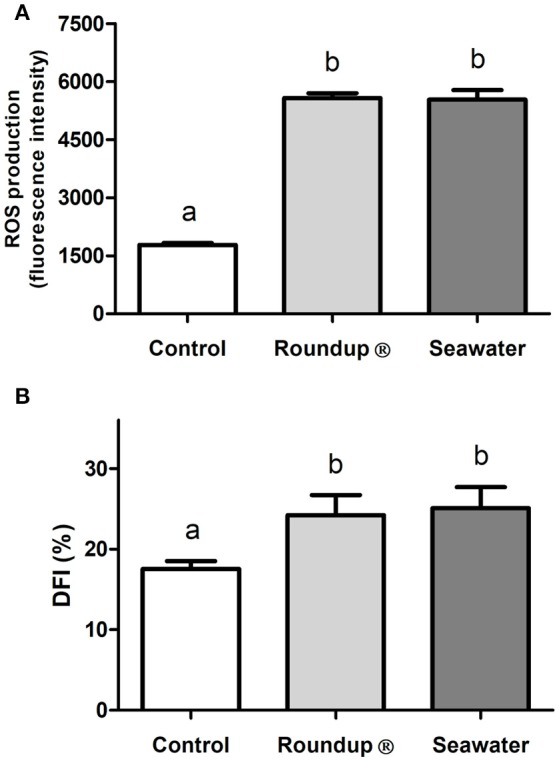
Effects in erythrocytes of Odontesthes humensis of exposures to Roundup® and to seawater. Effects of exposures to Roundup® Transorb [10 mg.L−1 (acid equivalent) of glyphosate] and to seawater (30 ppt) for 24 h on ROS (Reactive Oxygen Species) production (A) and in DFI (DNA Fragmentation Index, %) (B). Mean ± SEM, n = 9. Different letters represents significant statistical difference between the measurements of the treatment groups (P < 0.05).